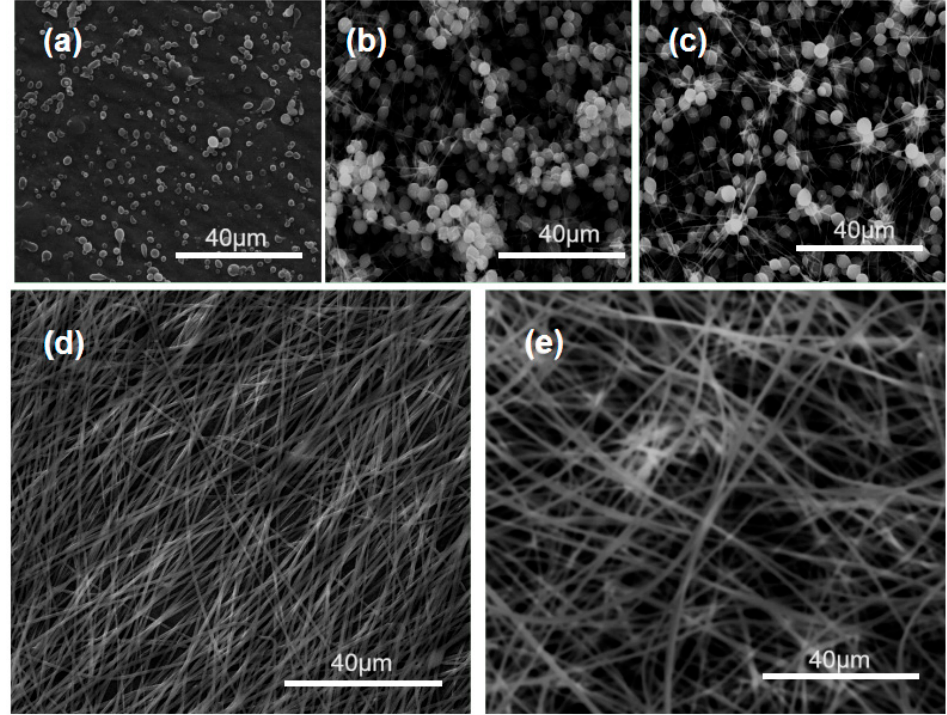
Figure 2. The studies about the electrospinnable concentrations of PVP: ( a ) F1—2%; ( b ) F2—4%; ( c ) F3—5%; ( d ) F4—6%; ( e ) F5—9%.